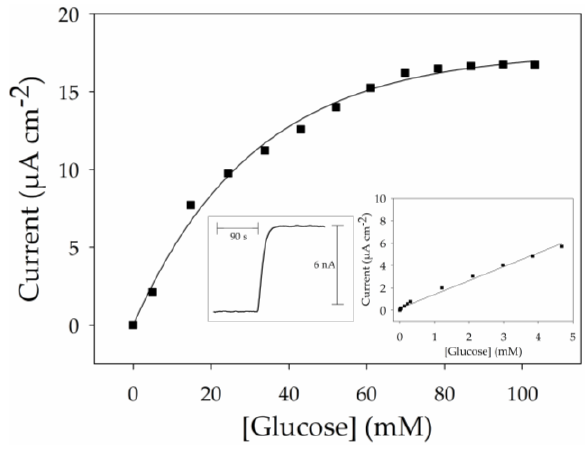
Figure 6. Response for amperometric glucose detection in 0.1 M PB at pH 7 for the range 5 to 110 mM. Inset, left: typical amperometric response obtained at 5 mM. Inset, right: linear calibration plot for the range 1 µM to 5 mM in 0.1 M PB at pH 7. Data recorded at 0.6 V vs . SCE at room temperature without stirring.